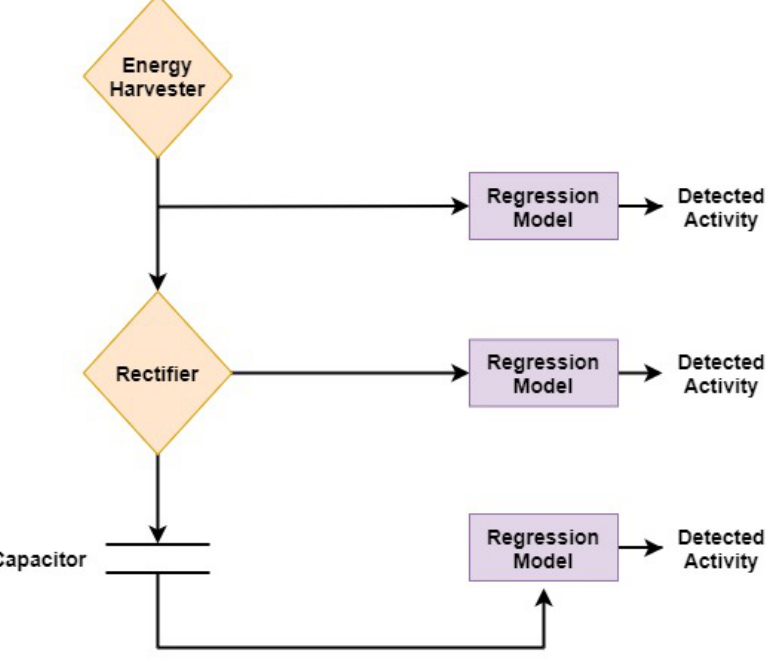
Figure 6. Types of signals from energy